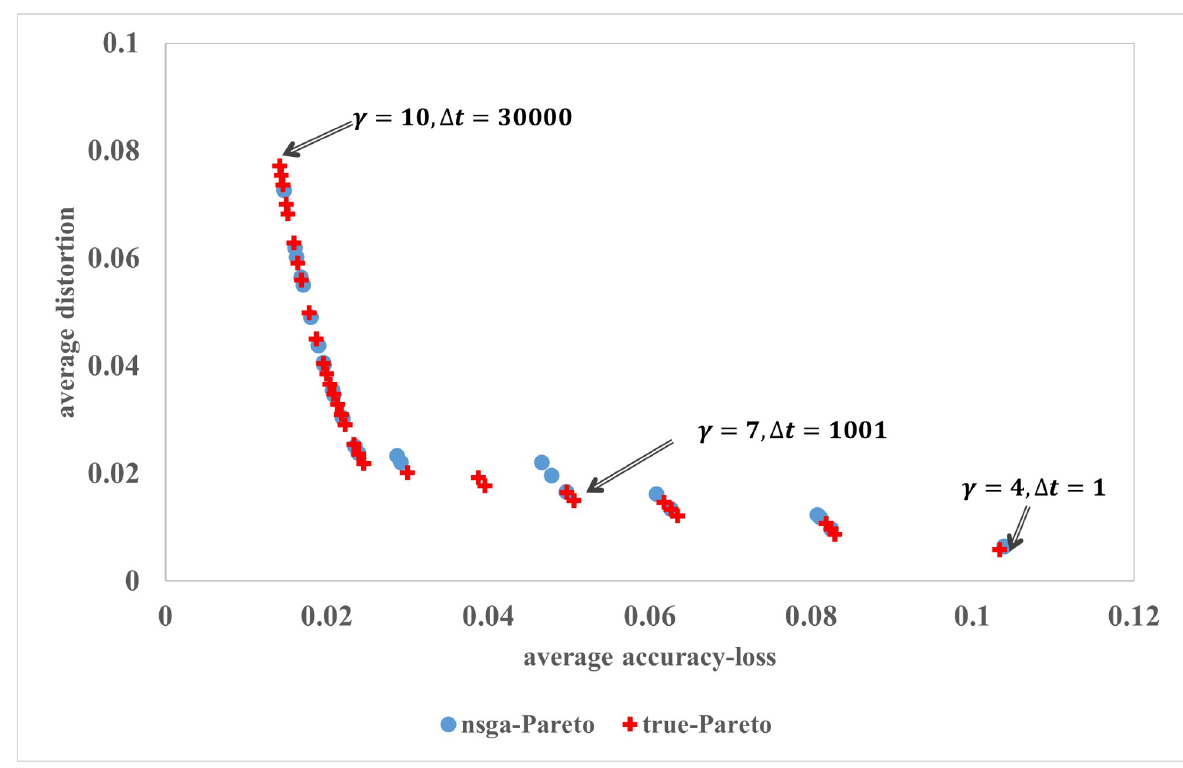
Fig 6. Pareto optimal front for